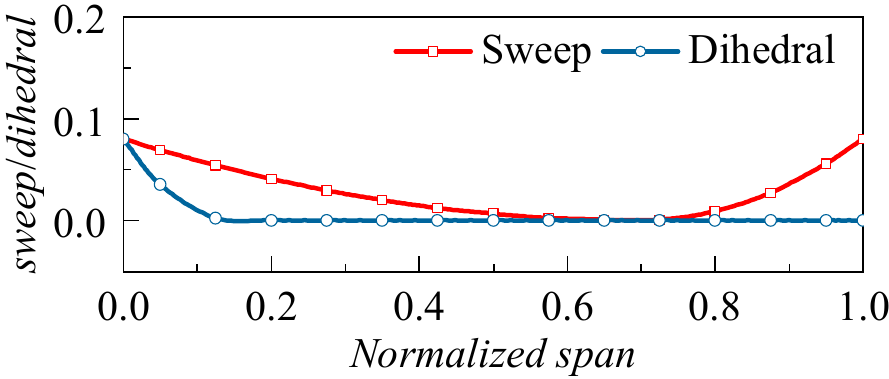
Figure 25. Radial distribution of sweep and dihedral for the 3D cantilevered stator.